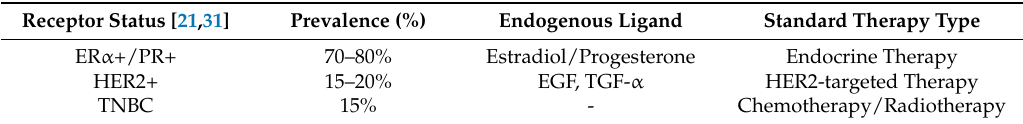
Table 1. Major breast cancer receptor sub-types and standard